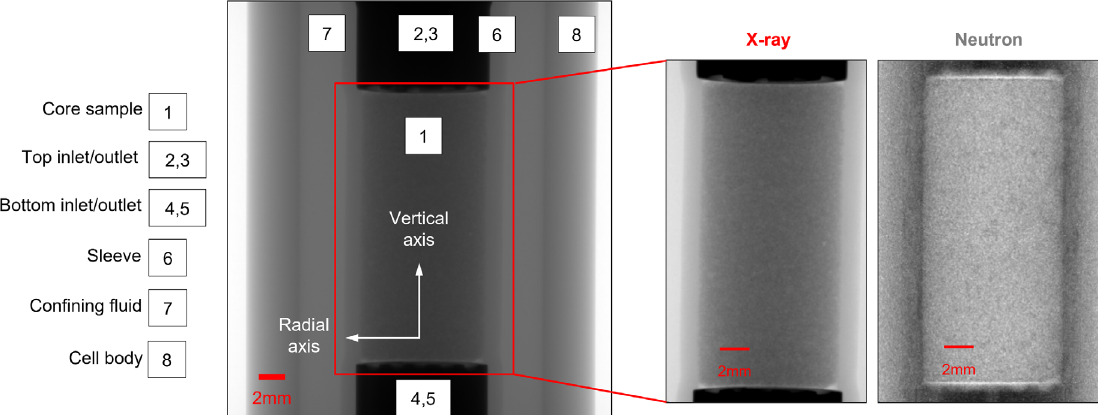
Fig. 1. Left: X-ray Radiography showing the Hassler injection cell. Right: X-ray and Neutron radiographies of the Bentheimer rock sample. X-ray and Neutron projections were acquired respectively at a pixel resolution of 40 l m and 15